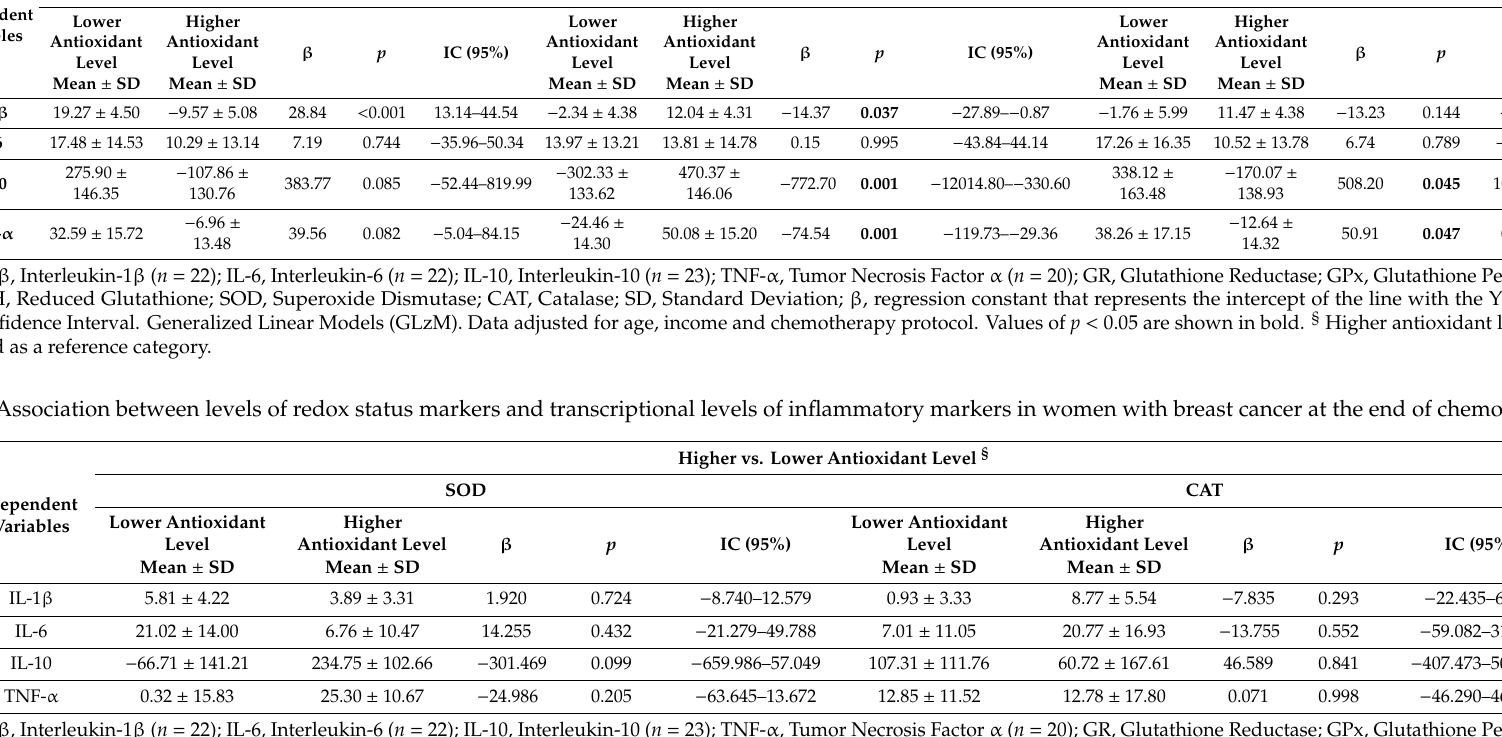
Table 5. Association between levels of redox status markers and transcriptional levels of inflammatory markers in women with breast cancer at the end of chemotherapy (T2). Dependent Variables